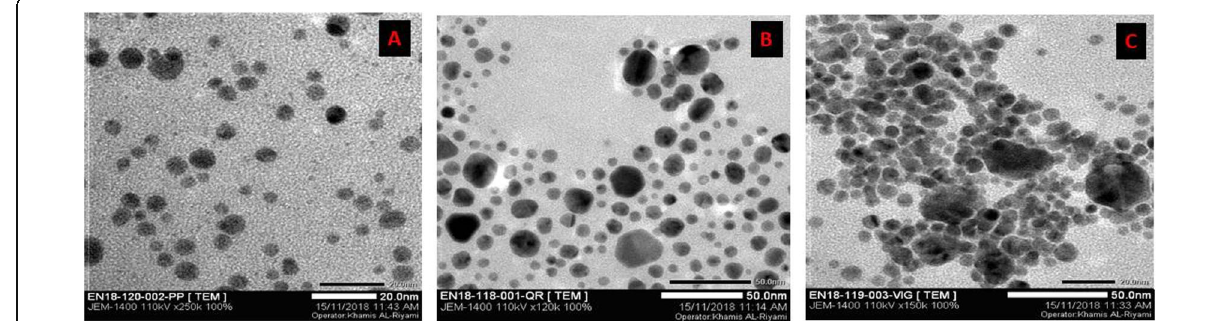
Fig. 4 a – c . TEM analysis of biosynthesized AgNPs. a P-AgNPs. b Q-AgNPs. c